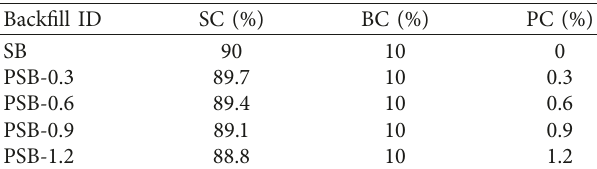
Table 4: The dosage of constituent soils and polymer in base